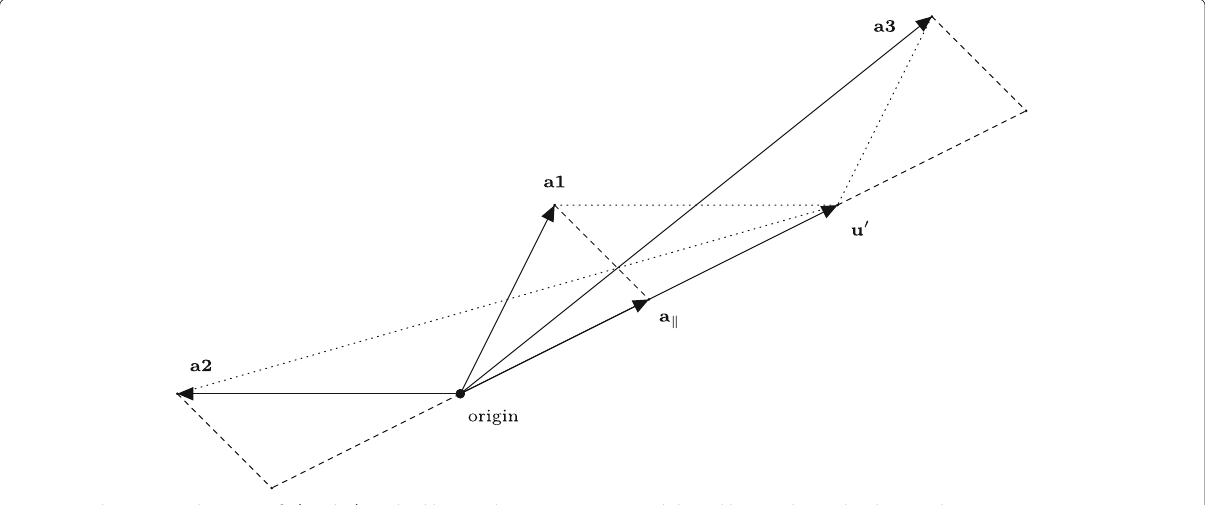
Fig. 18 Colinearity explanation of a (cid:18) and u (cid:18) . Dashed lines indicate projections and dotted lines indicate the distance between two